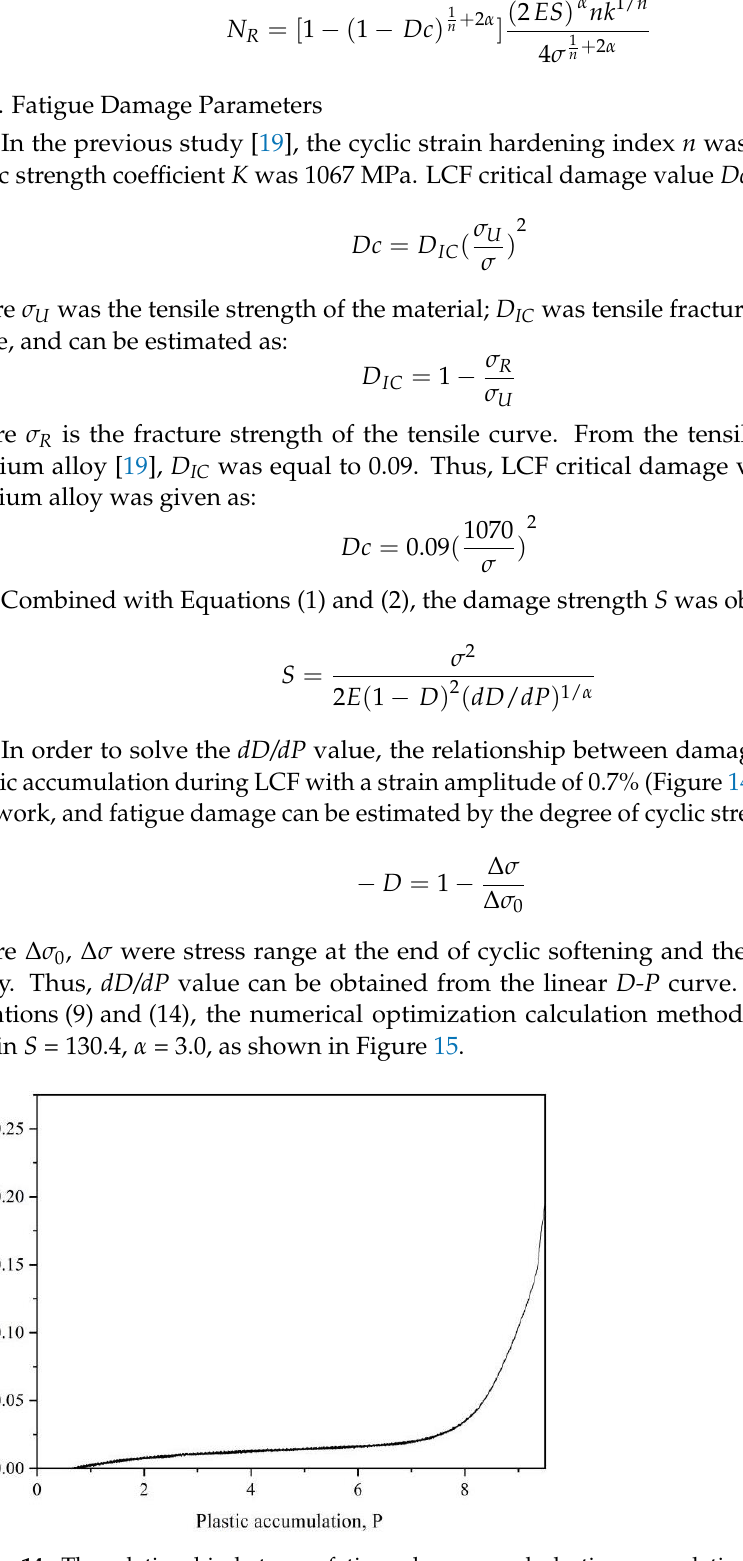
Figure 14 . The relationship between fatigue damage and plastic accumulation during low cycle fatigue under strain amplitude of 0.7%.